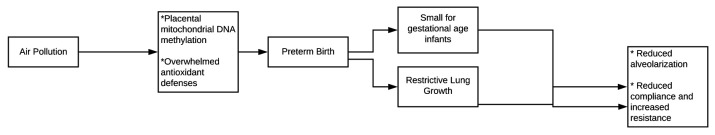
The role of air pollution in stunting and RLLF.